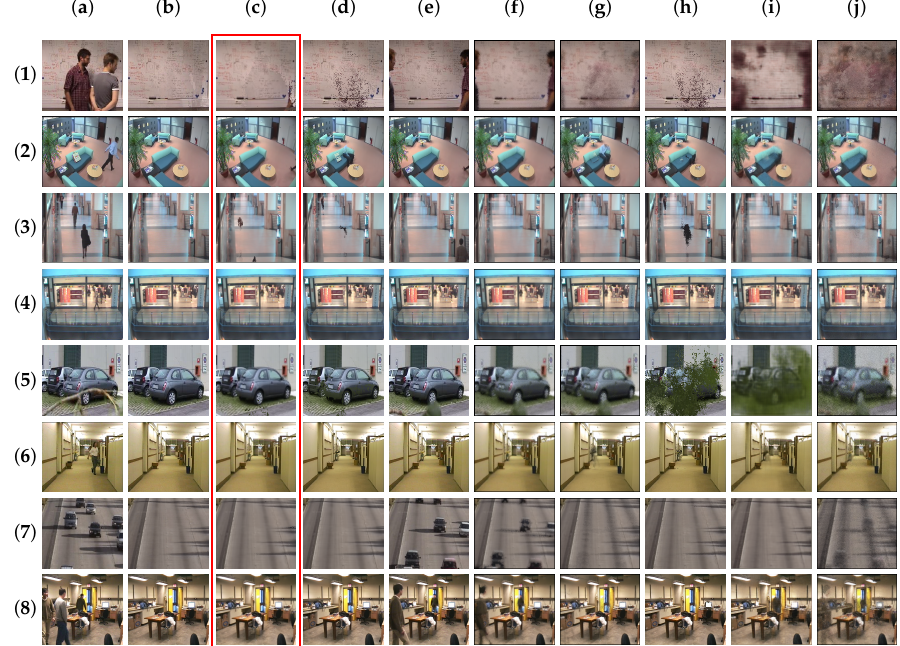
Figure 6. Visual quality comparison for background modelling on video sequences in SBI dataset. Some of SBI sequences: ( 1 ) sequence Board , ( 2 ) sequence Candela_m1.10 , ( 3 ) sequence CAVIAR1